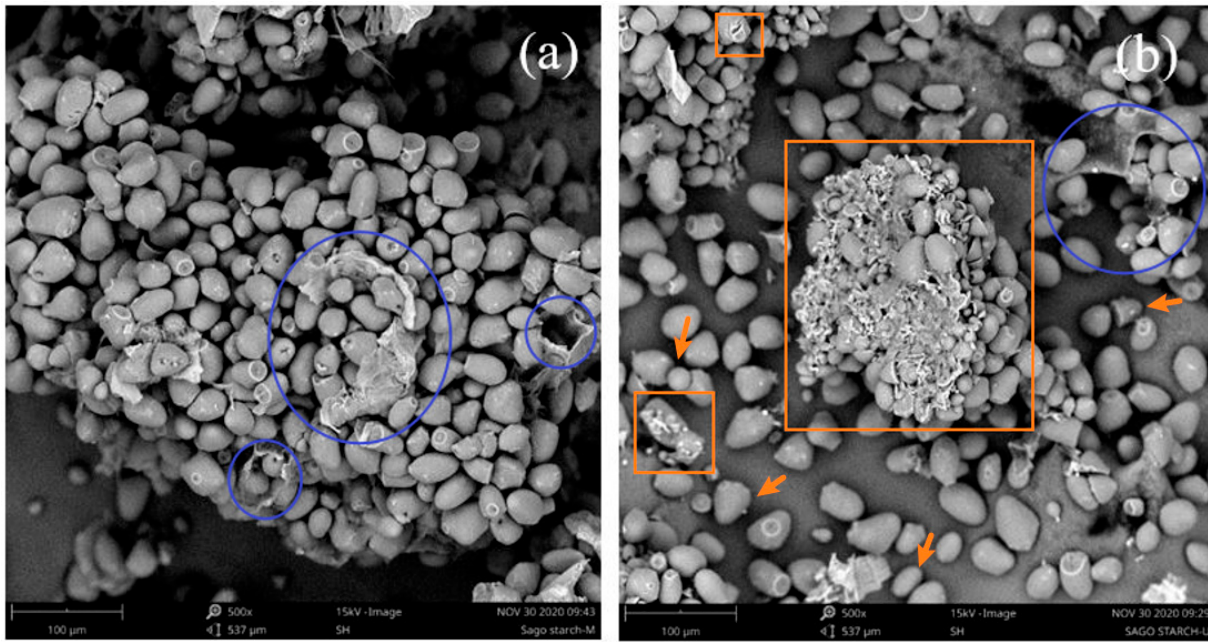
Figure 5. SEM micrographs of ( a ) control sago starch and ( b ) ultrasound-extracted sago starch at magnification of 500×. The cells that housed the starch granules were indicated by blue circle shapes; cracks and fissures were indicated by orange square shapes; structures of starch granules were indicated by orange arrows.